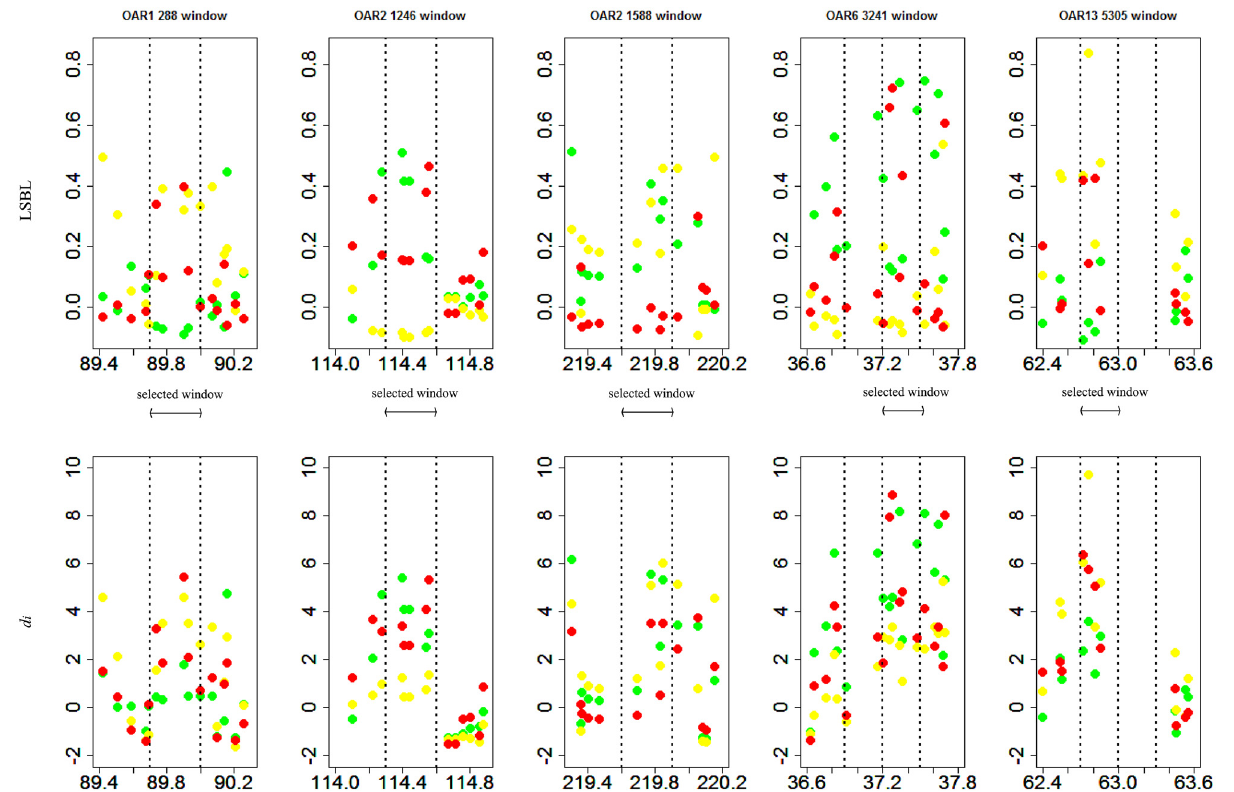
Fig 6. The two statistic of per-SNP of three regions with three consecutive windows, the selected widows in the middle, GMM: green dot, AWD: yellow dot, CMF: red